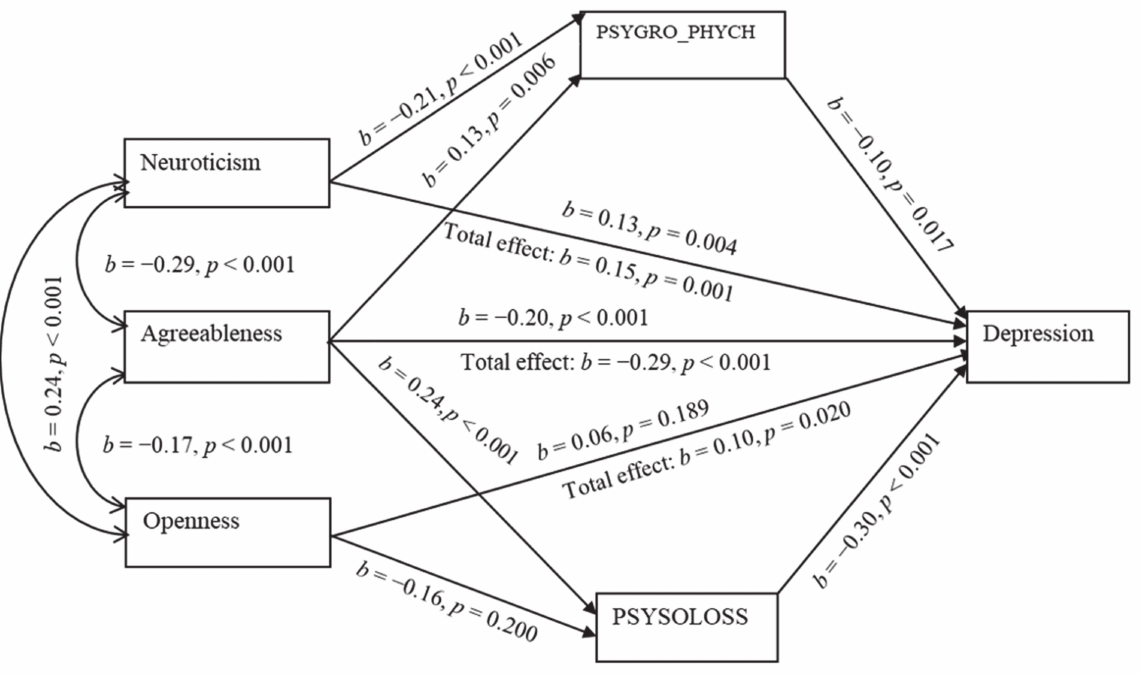
Figure 1. Mediation of AAQ subscales in the relationship between personality and